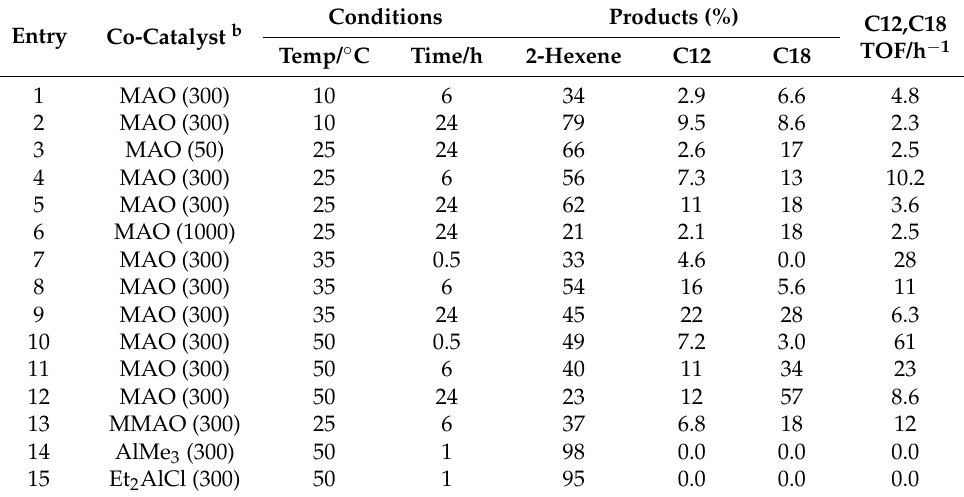
Table 2. Oligomerization of 1-hexene catalyzed by NiBr 2 ( L1 ) a